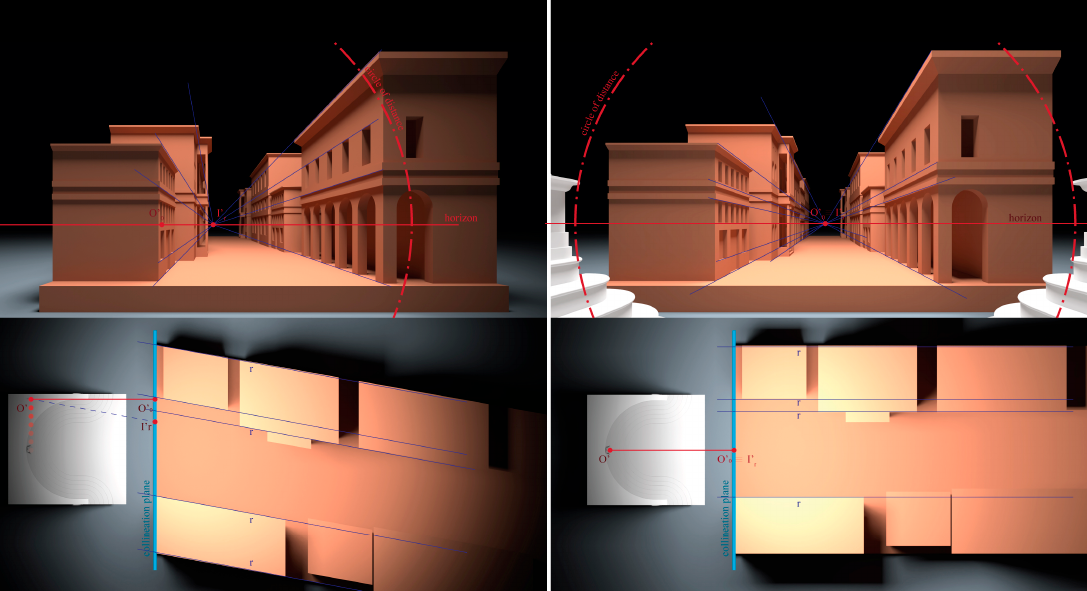
Figure 7. Reconstruction of the real space starting from two perspective of the same solid perspective seen from two different points of view: the center of projection and a generic position of the